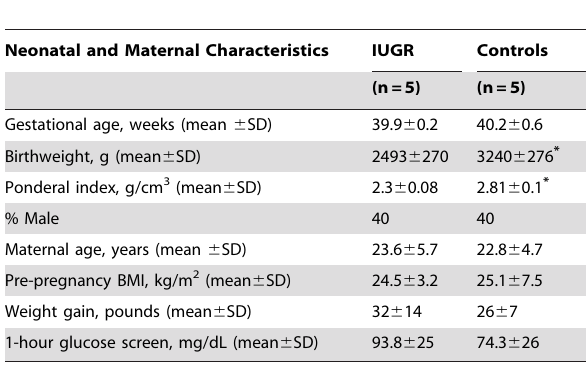
Table 1. Neonatal and Maternal Characteristics for IUGR and